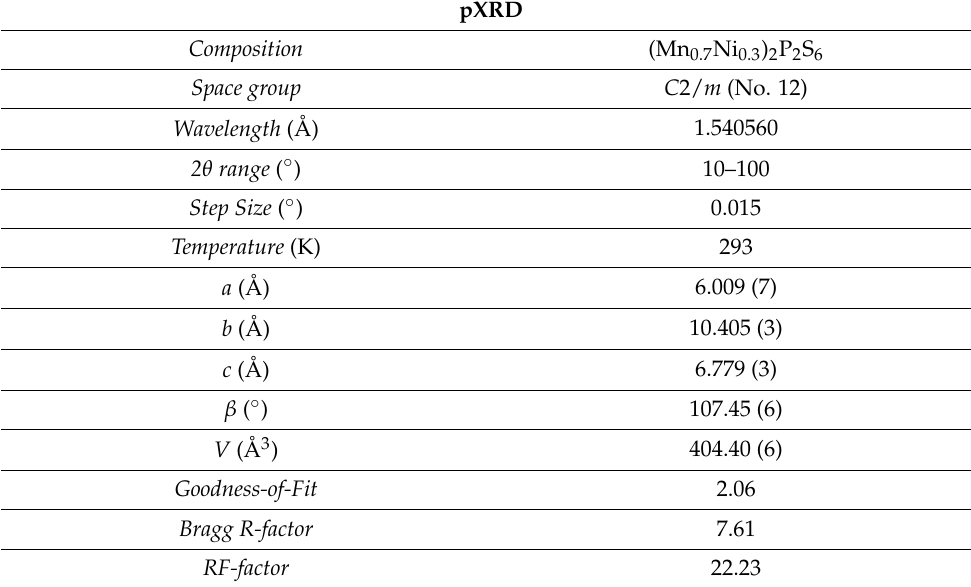
Figure 6. Rietveld analysis of (Mn 0.7 Ni 0.3 ) 2 P 2 S 6 . Table 2. Structural parameters and residual factors of Rietveld refinement. Table 2. Structural parameters and residual factors of Rietveld